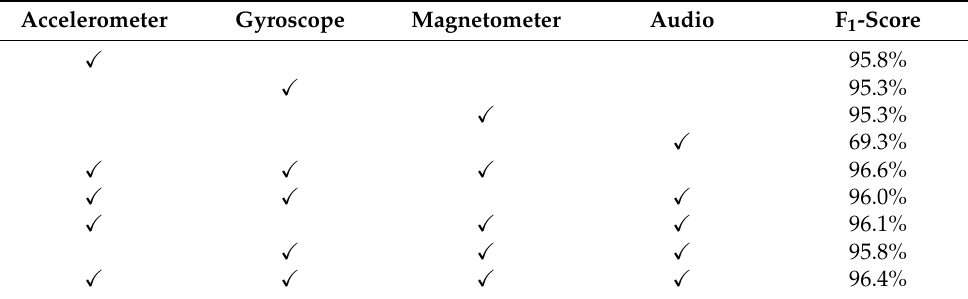
Table 5. Ablation study for the input values of the three-class ResNet.